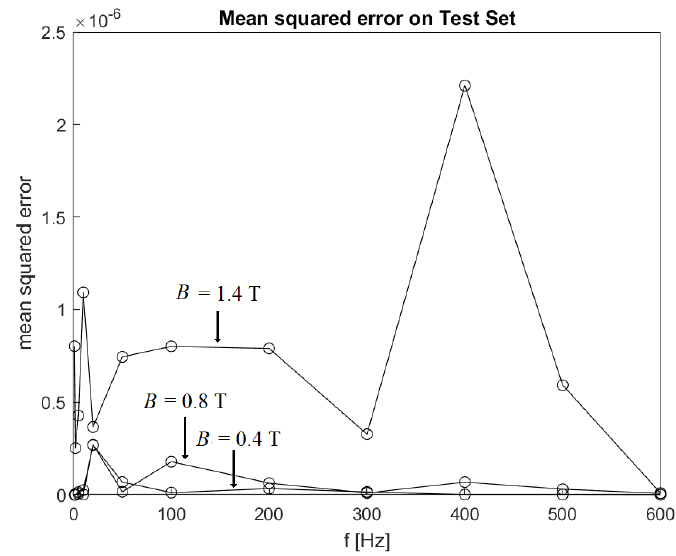
Figure 7. Mean-squared error related to the energy loss (Figure 5) on test set.